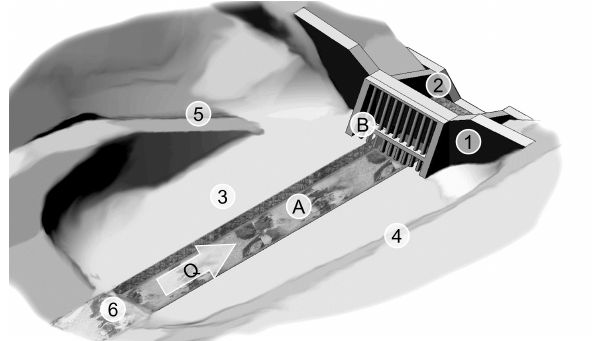
Figure 1. Concept of a permeable sediment trap consisting of (1) an open barrier (open sediment check dam) with overflow crest for flood release, followed by (2) downstream abutments with counter dam (sill); (3) a reservoir or deposition area, limited by (4) lat- eral dykes; (5) a maintenance access; and (6) an inlet structure with scour protection (adapted from Piton and Recking, 2016a; Zollinger, 1983). For permeable sediment traps, the novel element of (A) a guiding channel is introduced with (B) a barrier consisting of a bar screen for mechanical control and a barrier with an open- ing for the hydraulic control of bed load retention (Schwindt et al.,